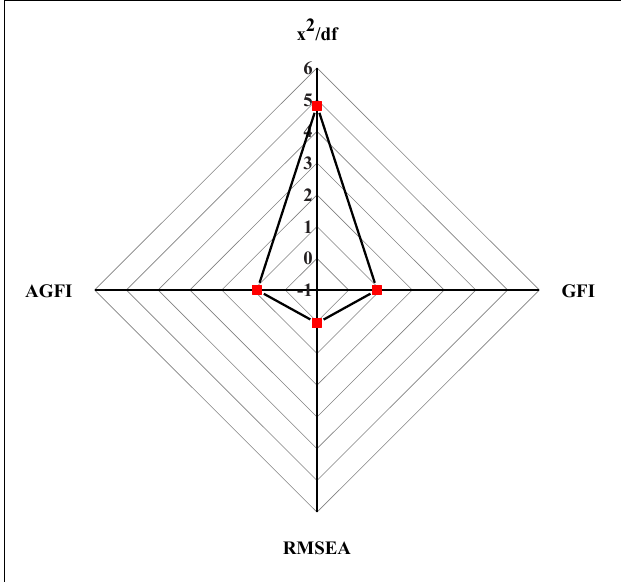
FIGURE 12 | Fitting value of the modified structural model.